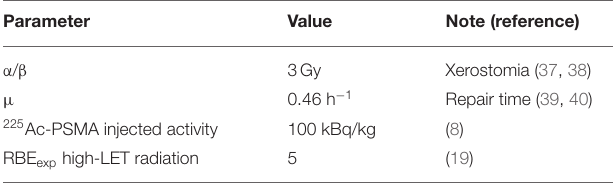
TABLE 2 | Value of parameters used for BED